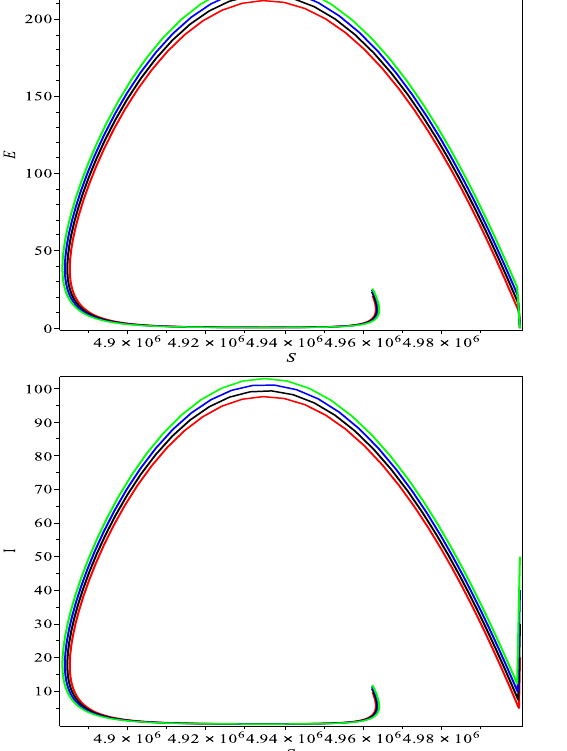
Fig. 2: Stability of the endemic equilibrium. Four trajectories in the S − E plane (upper) and the S − I plane (lower) ending in the endemic